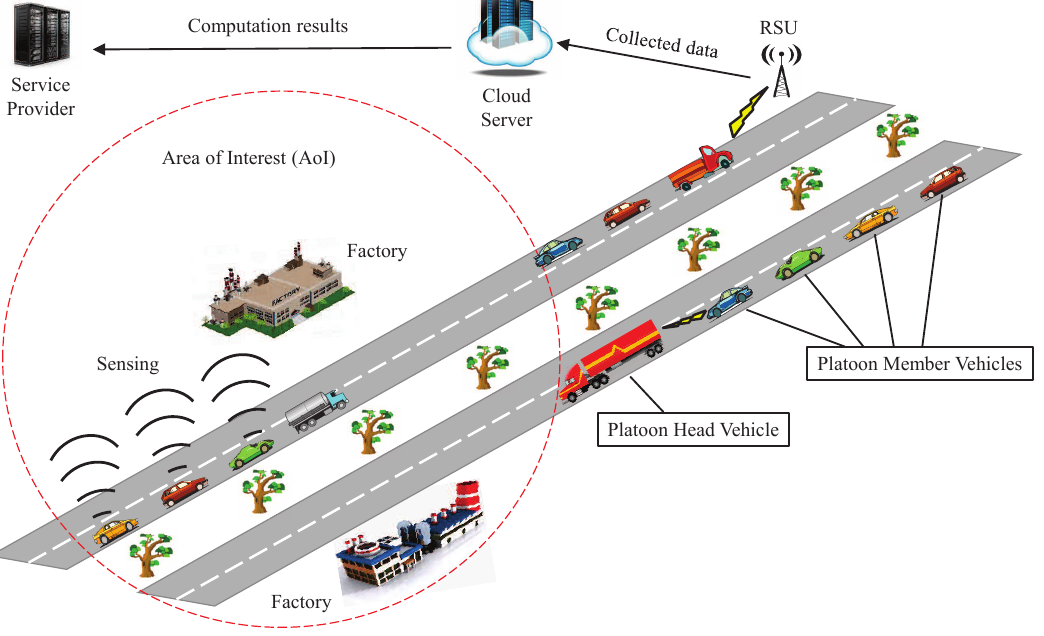
Figure 2. System model under